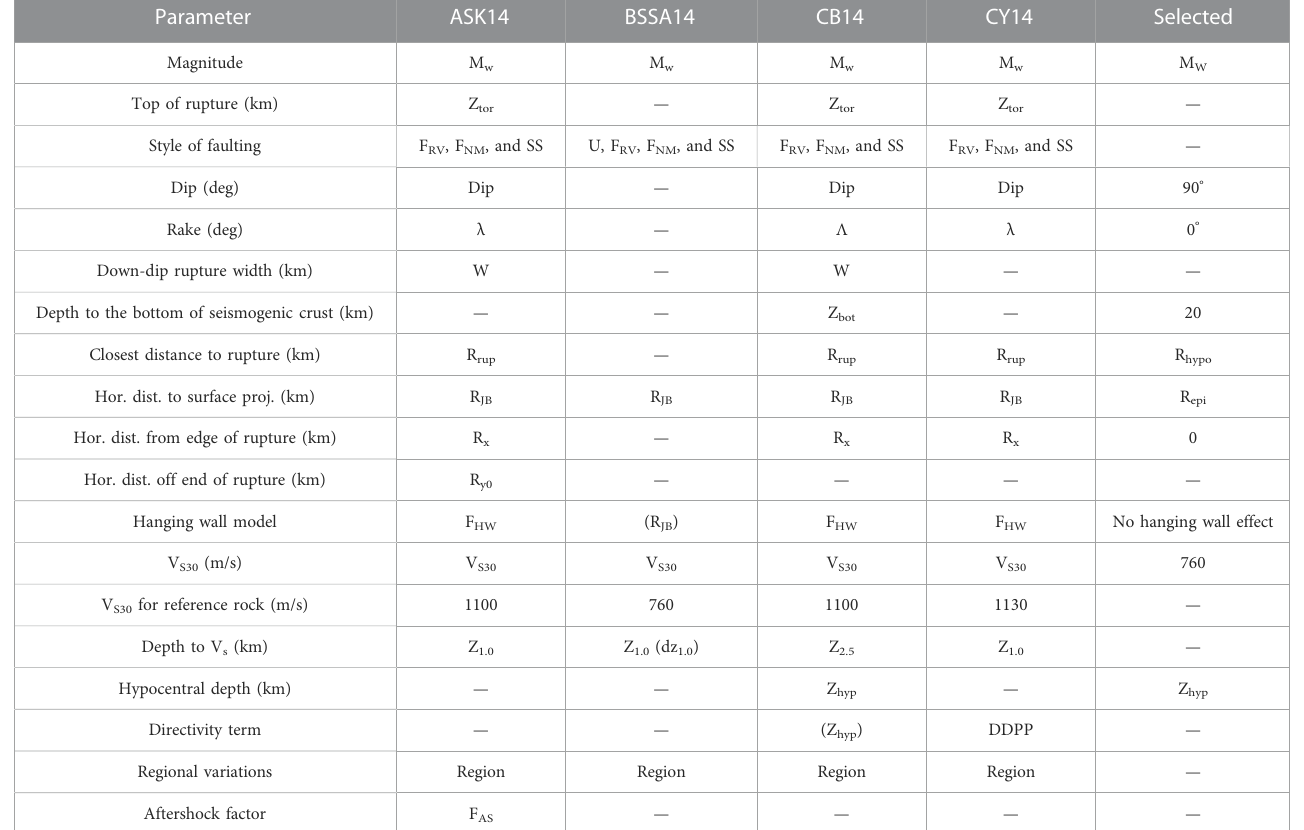
Region Region Region — Aftershock factor F AS —